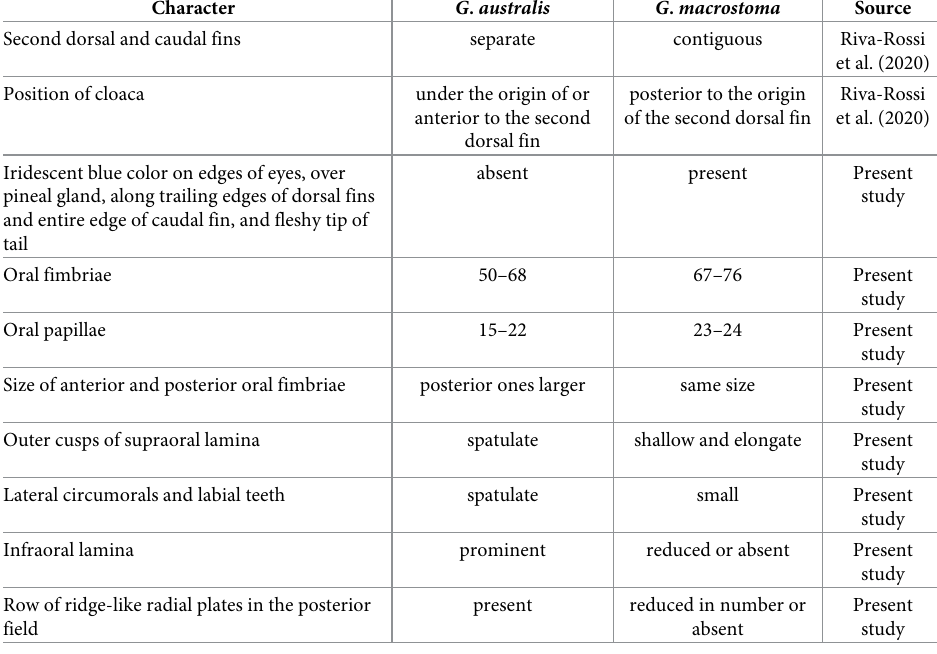
Table 4. Diagnostic characters in immature adults of Geotria .